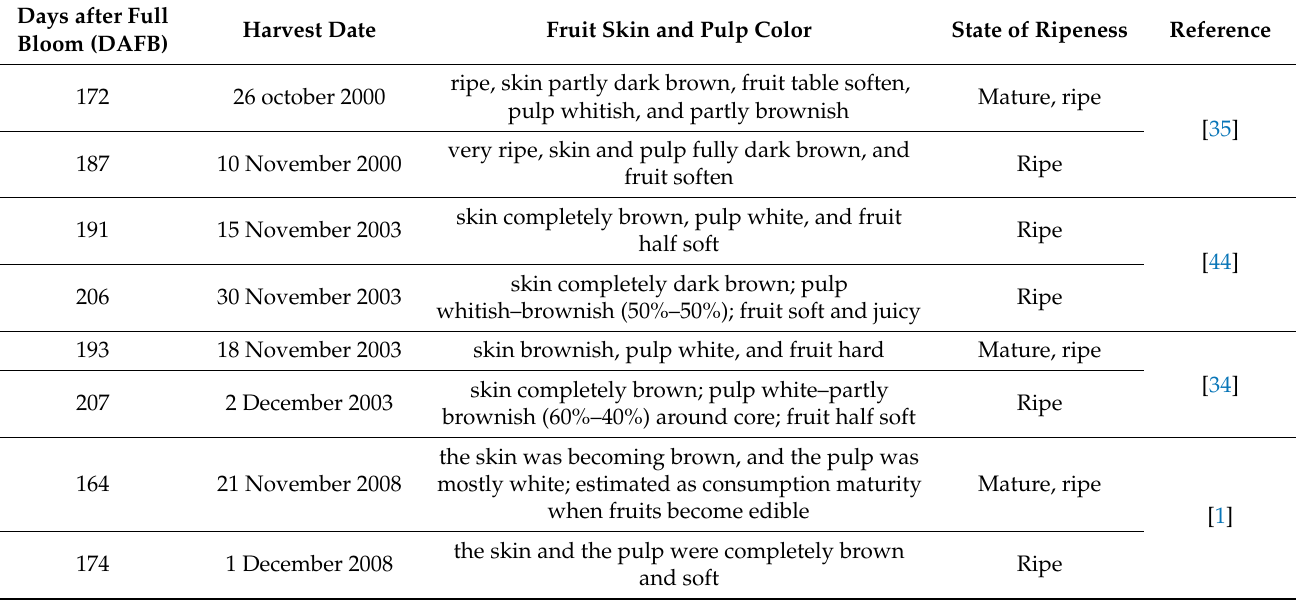
Table 3. Morphological characteristics of medlar